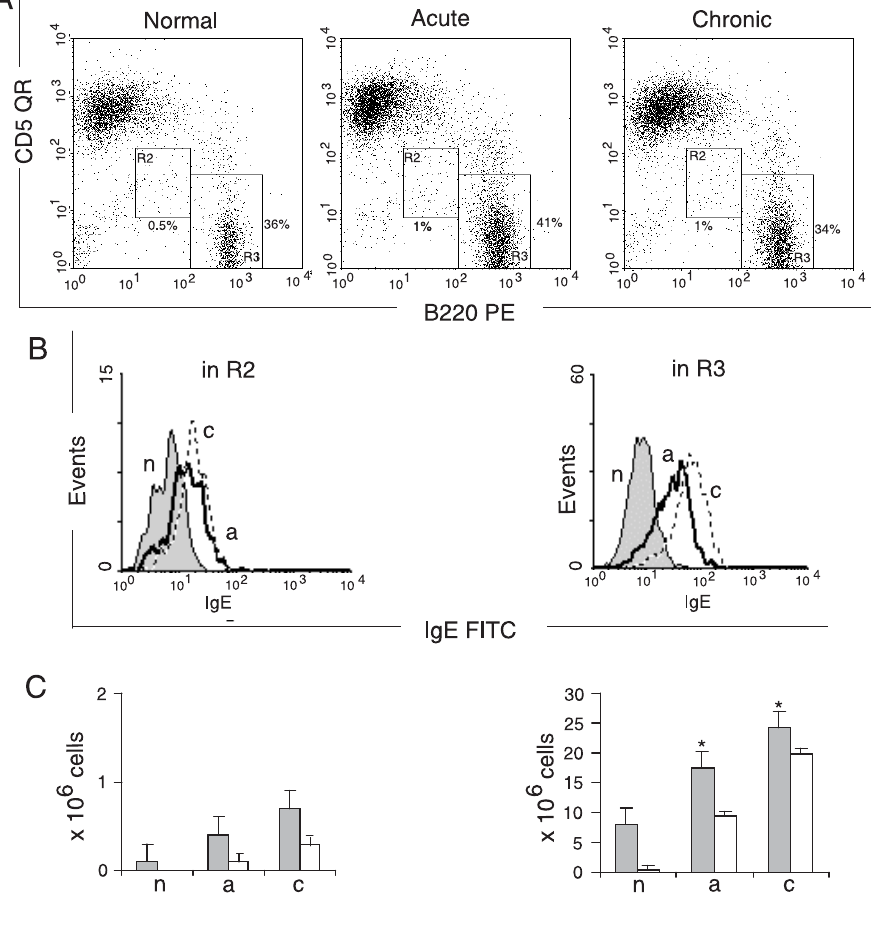
Figure 1 . Surface expression of B220, CD5 and IgE on cells from mesenteric ganglia. A , Dot plot of cells in the lymphocyte gate. The R2 and R3 regions repre- sent B1 and B2 cells, respec- tively. B , Intensity of IgE on the B-cell surface. C , Total cell num- bers (filled columns) and IgE+ cells (open columns). Data are reported as means ± SEM and are representative of five inde- pendent experiments, each car- ried out in 2 normal mice (n), 5 mice with acute infection (a) and 5 with chronic infection (c). *P < 0.05 for B-IgE + cells compared to total B cells (Tukey multiple comparison